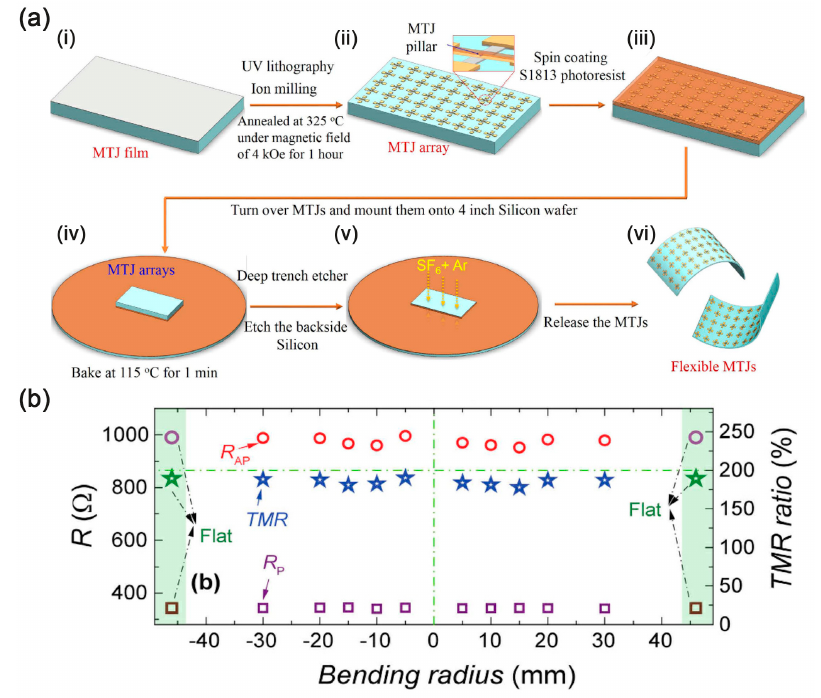
Figure 11. ( a ) Schematics on the fabrication process of flexible TMR sensors; (i) MgO-barrier MTJ